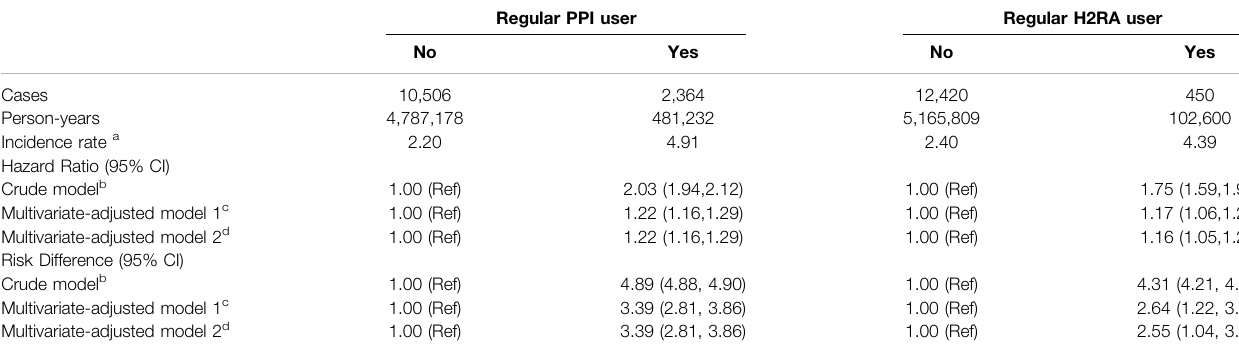
TABLE 2 | Associations between regular PPI/H2RA use and risk of